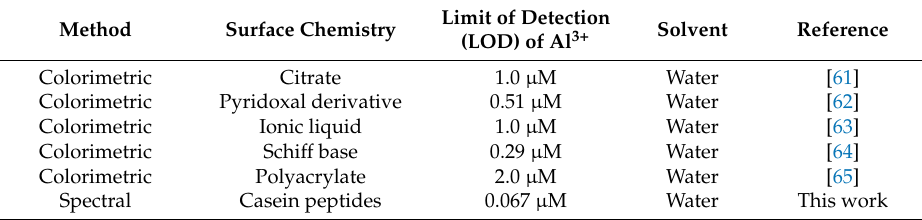
Table 1. Literature values reported for the detection of Al 3+ contents in a reasonable range using different colorimetric